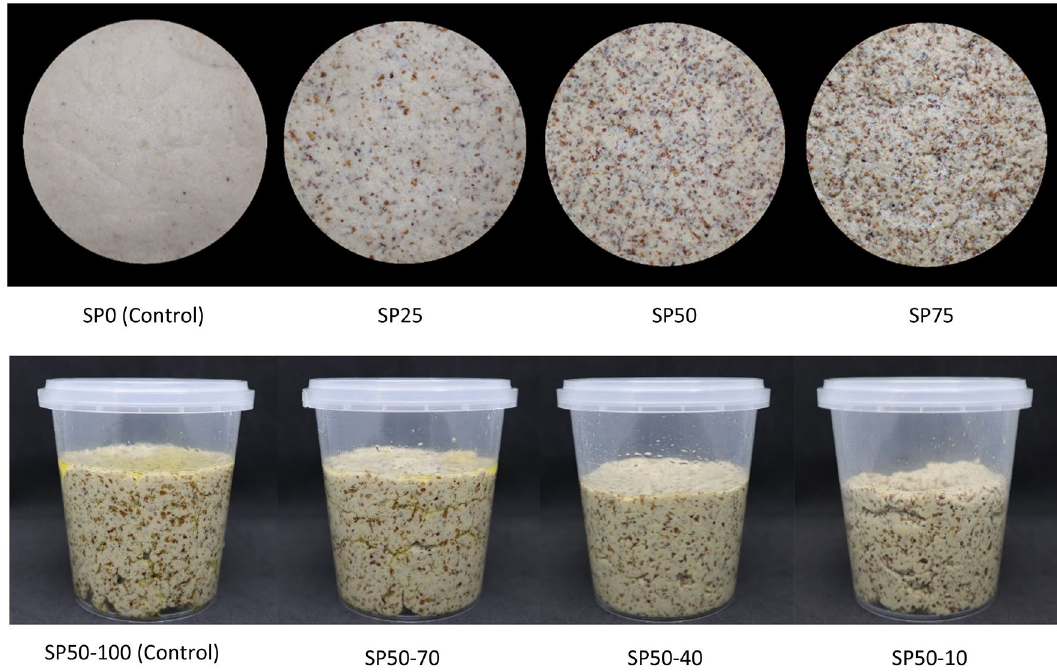
Figure 2. The characteristics of chicken bread spread-fortified with silkworm pupae. SP0, SP25, SP50, and SP75: Silkworm pupae-fortified chicken bread spread with the replacement of chicken meat at 0% (Control for experiment 1; without fortification), 25, 50, and 75%, respectively. SP50-100, SP50-70, SP50-40, and SP50-10: Chicken bread spread with 50% replacement of chicken meat by silkworm pupae using 100% (Control for experiment 2), 70, 40, and 10% of coconut oil in control sample of experiment 1,